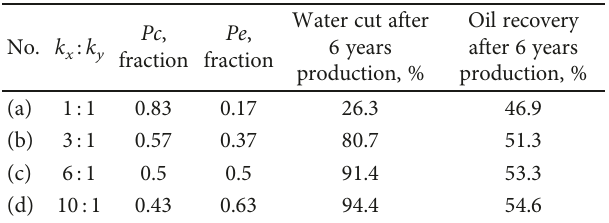
Figure 5: Three-dimensional color map surface of oil recovery with no fractured injection well. (a) Reservoir permeability k reservoir permeability k Table 3: Optimal penetration ratio of production well fracture when the injection well is not fractured.